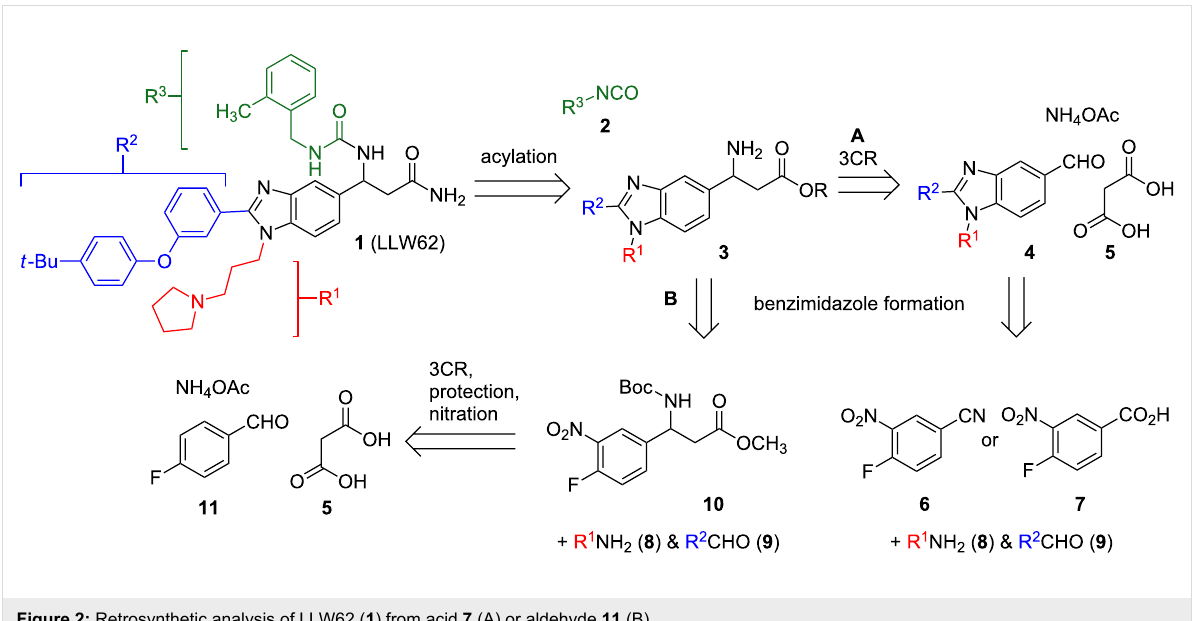
Figure 2: Retrosynthetic analysis of LLW62 ( 1 ) from acid 7 (A) or aldehyde 11 (B).